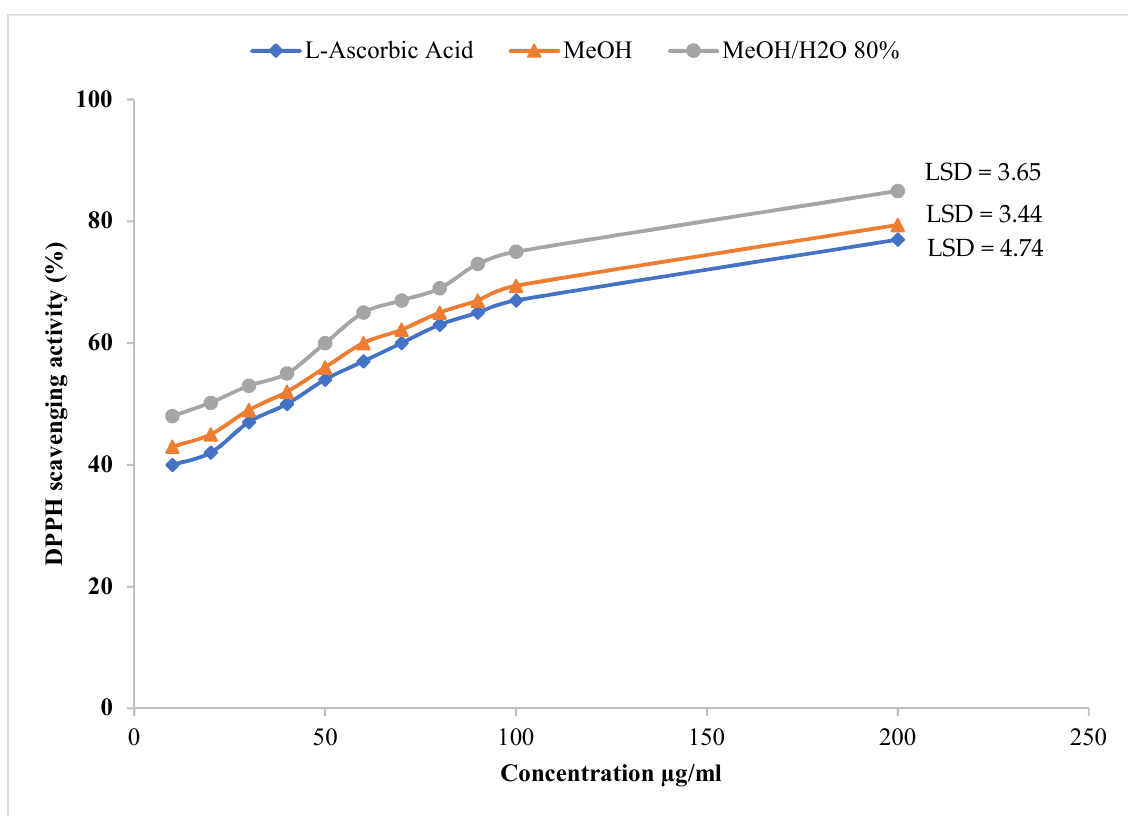
Figure 1. DPPH FRSA of MeOH/H 2 O 80% and MeOH leaf extracts of R. gallica var. aegyptiaca , compared with L-ascorbic acid (AA) ( n = 3). LSD as a post hoc test at p ≤ 0.05 was used to separate the means of the treatments.